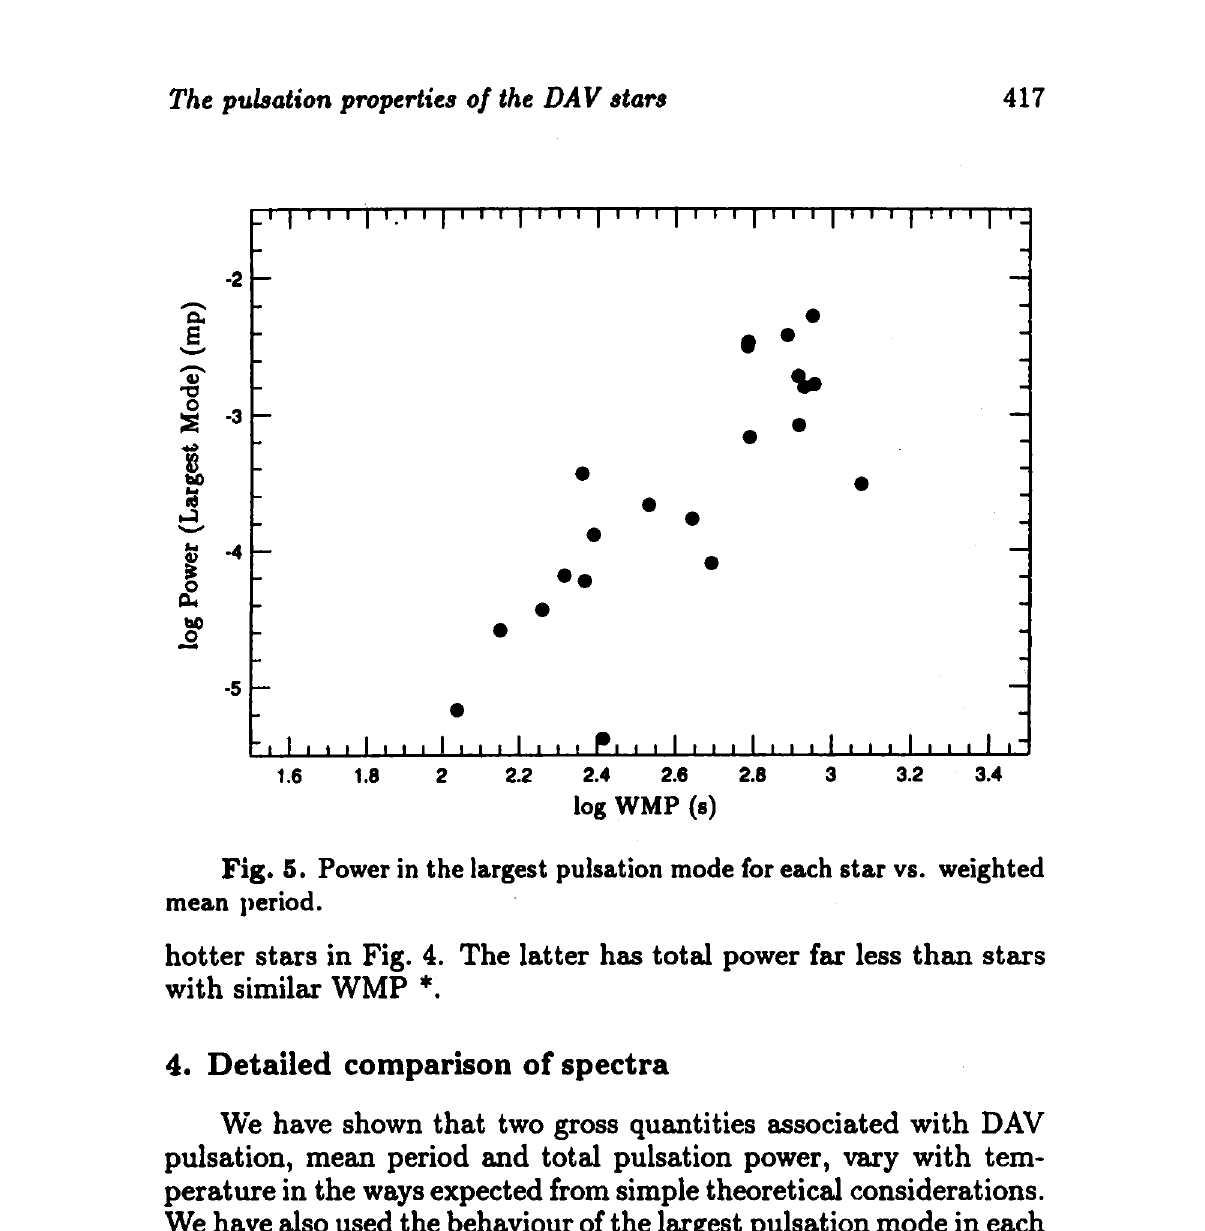
Fig. 5. Power in the largest pulsation mode for each star vs. weighted mean